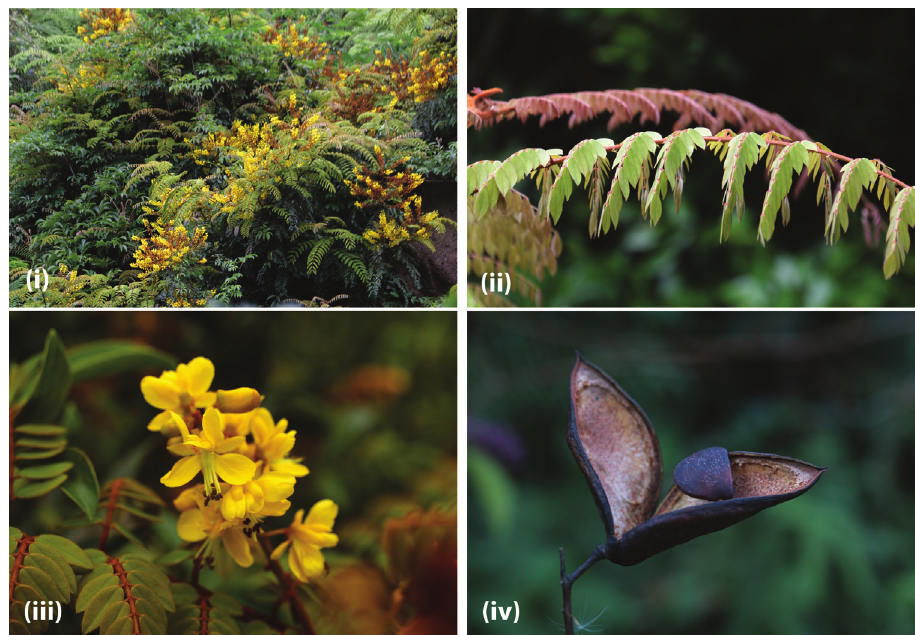
Figure 4. T. vernalis ( i ) habit ( ii ) leaves ( iii ) flowers ( iv ) fruit (photos by Jian-Ping Wu, Zhejiang, China, unvouchered